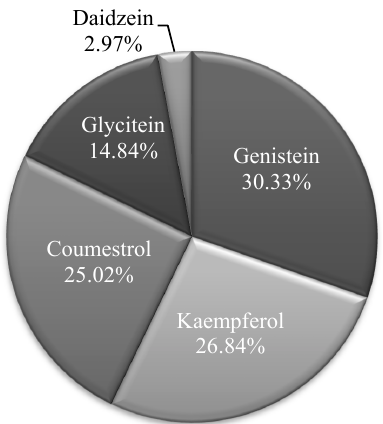
Figure 2. Proportion (%) of individual phytoestrogens in the total amount of all alfalfa populations.